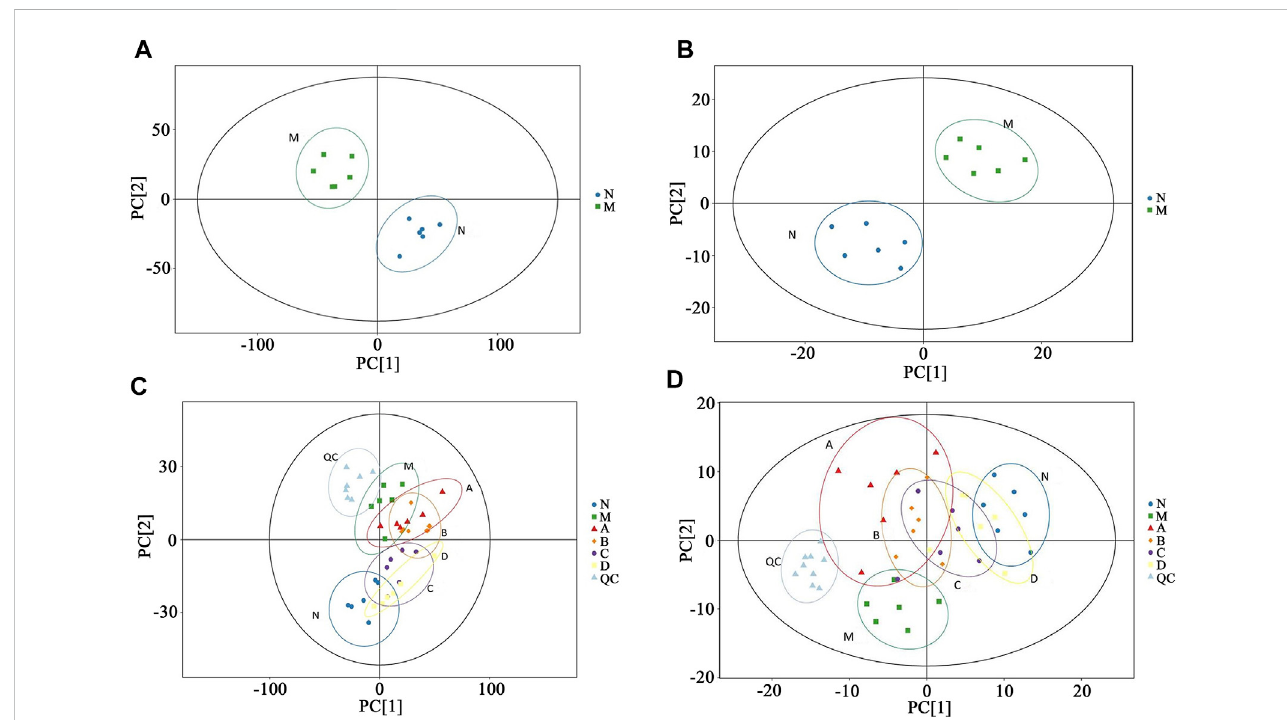
FIGURE 4 PCA scores plots of urine and plasma samples in rats N: Control group; M: Model group; A: Suet oil group; B: Epimedium raw product group; C: Epimedium heating product group; D: Epimedium fried with suet oil group. (N VS . M, (A) Urine, (B) Plasma; the PCA scores plots of six group, (C) Urine, (D)